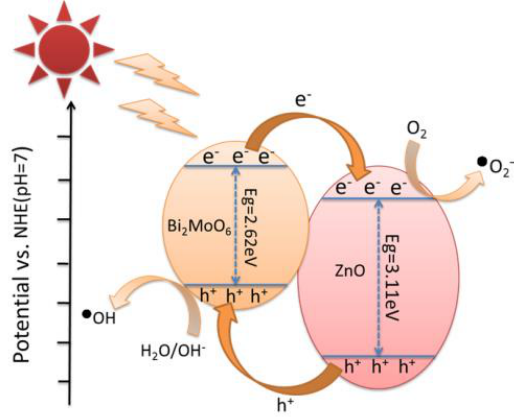
Figure 12. Photocatalytic mechanism of BZOunder visible light.